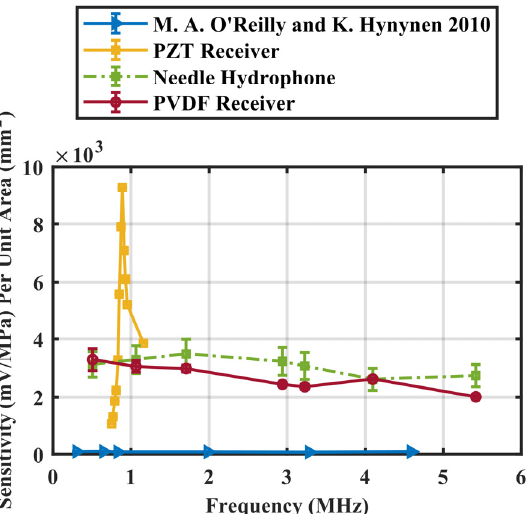
Figure 4. Sensitivity per unit area (mm 2 ) of a PVDF receiver compared to the receiver by O’Reilly and Hynynen (Data from M.A. O’Reilly) [20], a needle hydrophone, and a PZT receiver fabricated in house (calibrated from 750 to 950 kHz and 1.16 MHz). Preamplifier characteristics are corrected. Error bar indicates one standard deviation.